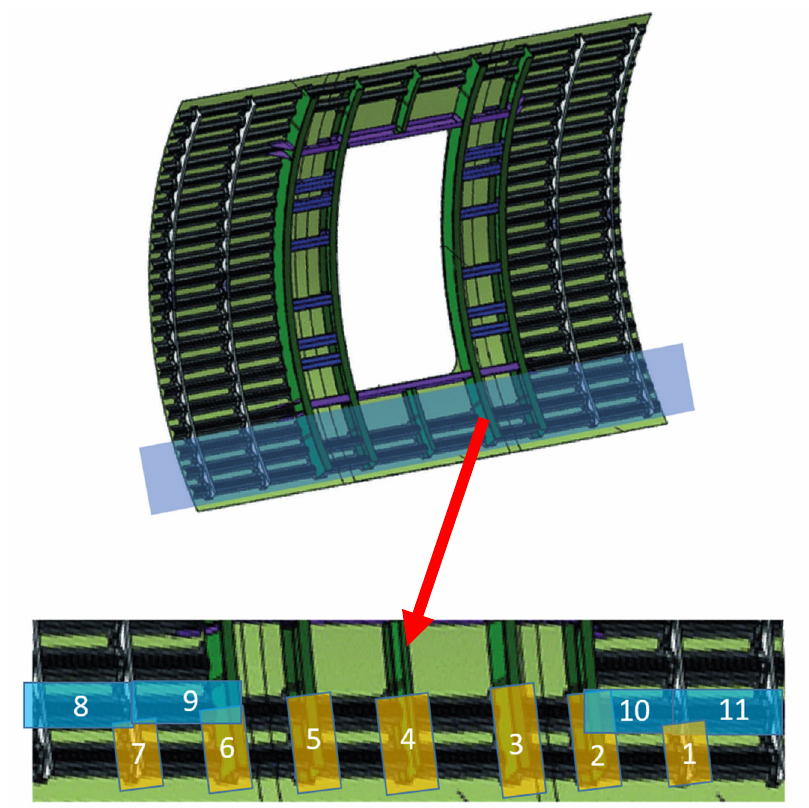
Figure 4. Aircraft panel considered in the case study (CAD drawing courtesy of [39]).